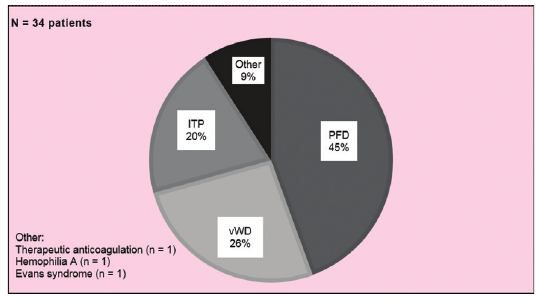
Fig. 1 Bleeding disorder diagnoses in adolescents hospitalized for HMB.